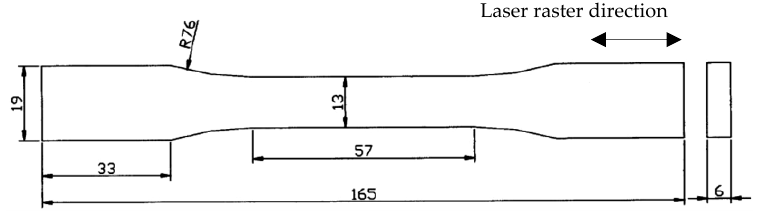
Figure 2. Geometrical properties of test specimen according to the ASTM D638 standard. All dimensions in mm.